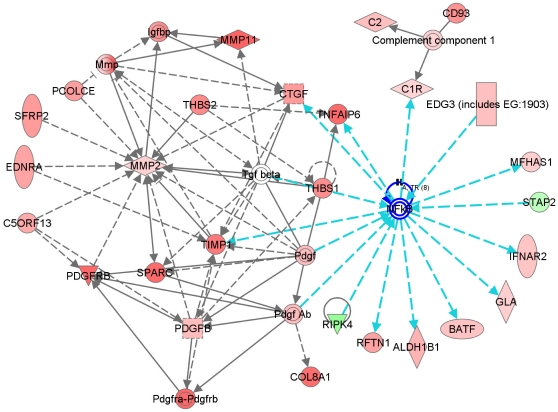
Gene networks from IngenuityTM Pathway Analysis.Global networks of inter-connection among genes and expression patterns of genes in network #1 in Appendix Table 1. Red and green colors in each shape indicate up- or down-regulation of expression in cluster B when compared with cluster A and C. Genes in gray color are not in the list but associated with the regulated genes. Each line and arrow represents functional and physical interaction and direction of regulation demonstrated in the literature. Genes inter-connected with NF-kB are highlighted in blue lines.